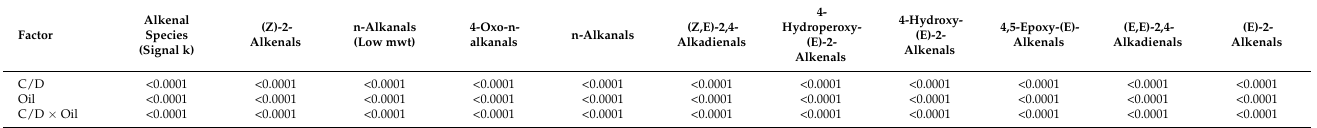
Table 7. Statistical significance of main factors (continuous (C) versus discontinuous (D) thermal- stressing methods (C/D) and oil type, and their first-order interaction effect, obtained from an ANOVA analysis of the aldehydic LOP dataset (Model 2).